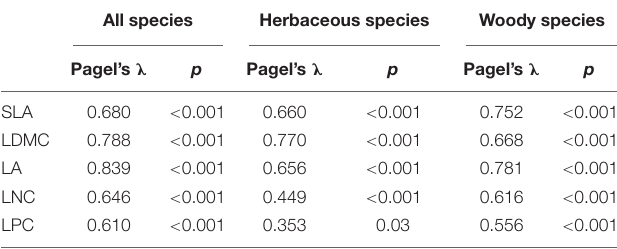
TABLE 2 | Phylogenetic signals of the leaf traits evaluated. All species